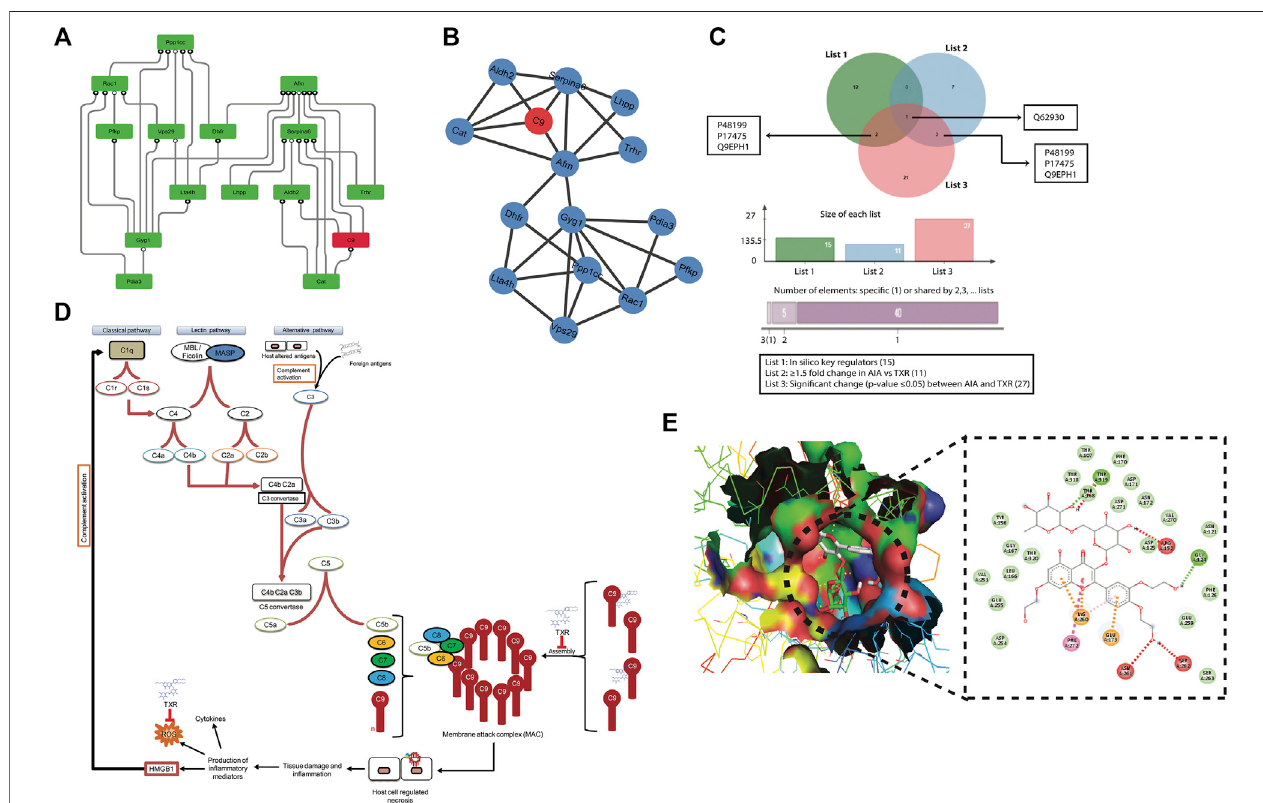
FIGURE 6 | Mechanism of action study of TXR (A) Protein – protein interaction (PPI) of all 15 key regulator proteins computationally derived through the community fi ndingmethod. (B) Stringinteractionnetworkofthe15 insilico keyregulatorproteins.ThePPInetworkswereconstructedusingSTRING10.0withamediumcon fi dence level (0.4) and all available prediction methods. (C) Venn diagram showing C9 as the common protein in all the lists of proteins, viz., list 1 = 15 proteins ( in silico key regulators), list 2 = 11 proteins ( ≥ 1.5 fold expressed proteins in AIA when compared with the TXR group), and list 3 = 27 proteins (signi fi cantly differentially expressed( p ≤ 0.05)proteinsbetweenAIAandTXR). (D) ProbablestepofTXRactiononC9-basedmembraneattackcomplexformationanditsroleinin fl ammationand arthritis. (E) Molecular docking ofC9proteinwithTXR.Expandedregionofthedockingsite showstheinteractingaminoacidsofC9proteinwiththeTXRmoleculeinthe